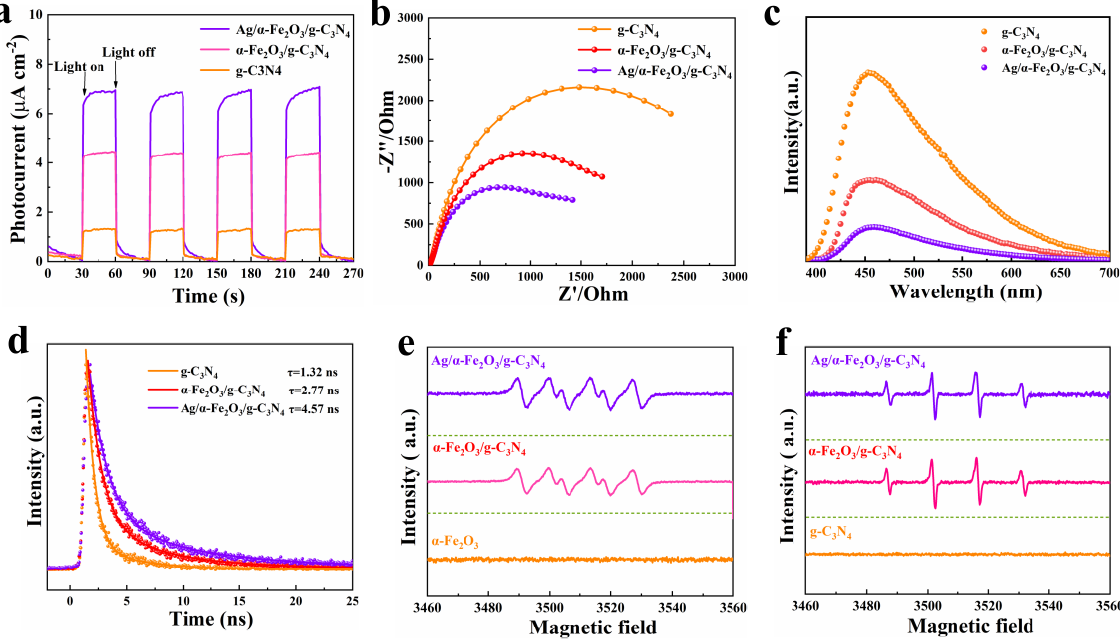
Figure 7. Photocurrent curves ( a ), impedance experiments ( b ), PL spectra ( c ), TRPL spectra ( d ), DMPO- · O – signals under light ( e ), DMPO- · OH signals under light ( f ) of g-C 3 N 4 , α -Fe 2 O 3 /g-C 3 N 4 2 and Ag/ α -Fe 2 O 3 /g-C 3 N 4